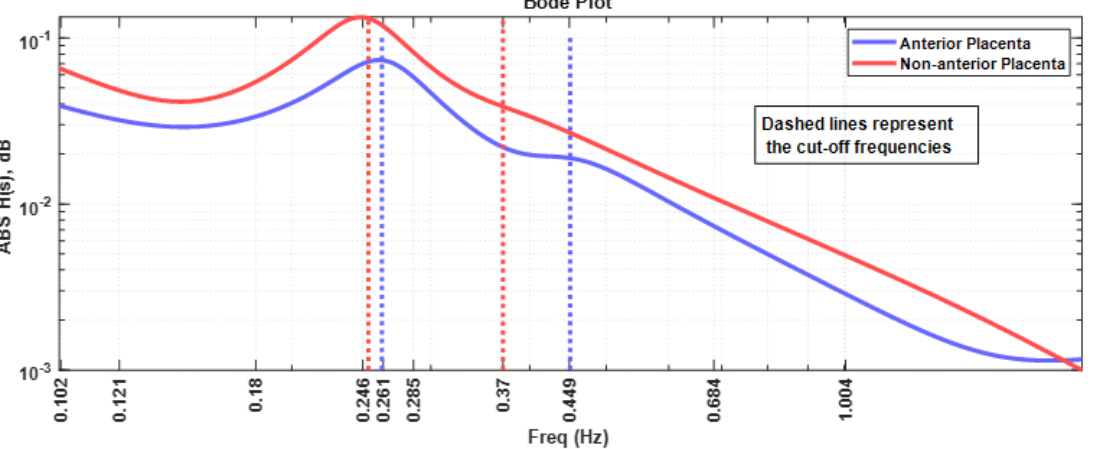
Figure 8. Bode plot of the myometrial impedance for the anterior placental and non-anterior pla- cental cases. The cut-off frequencies are represented by the dash lines with the same colour as the respective curves.